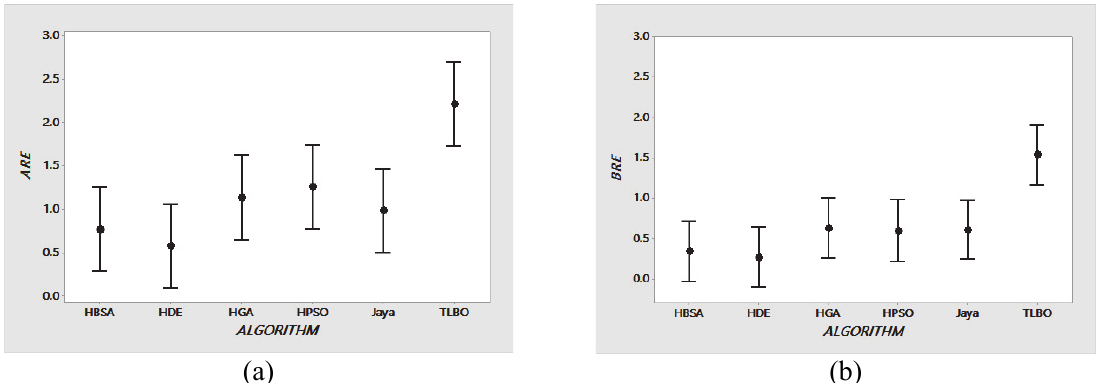
Fig 5. Mean plots of performance measures for various algorithms (a) ARE values (b) BRE values